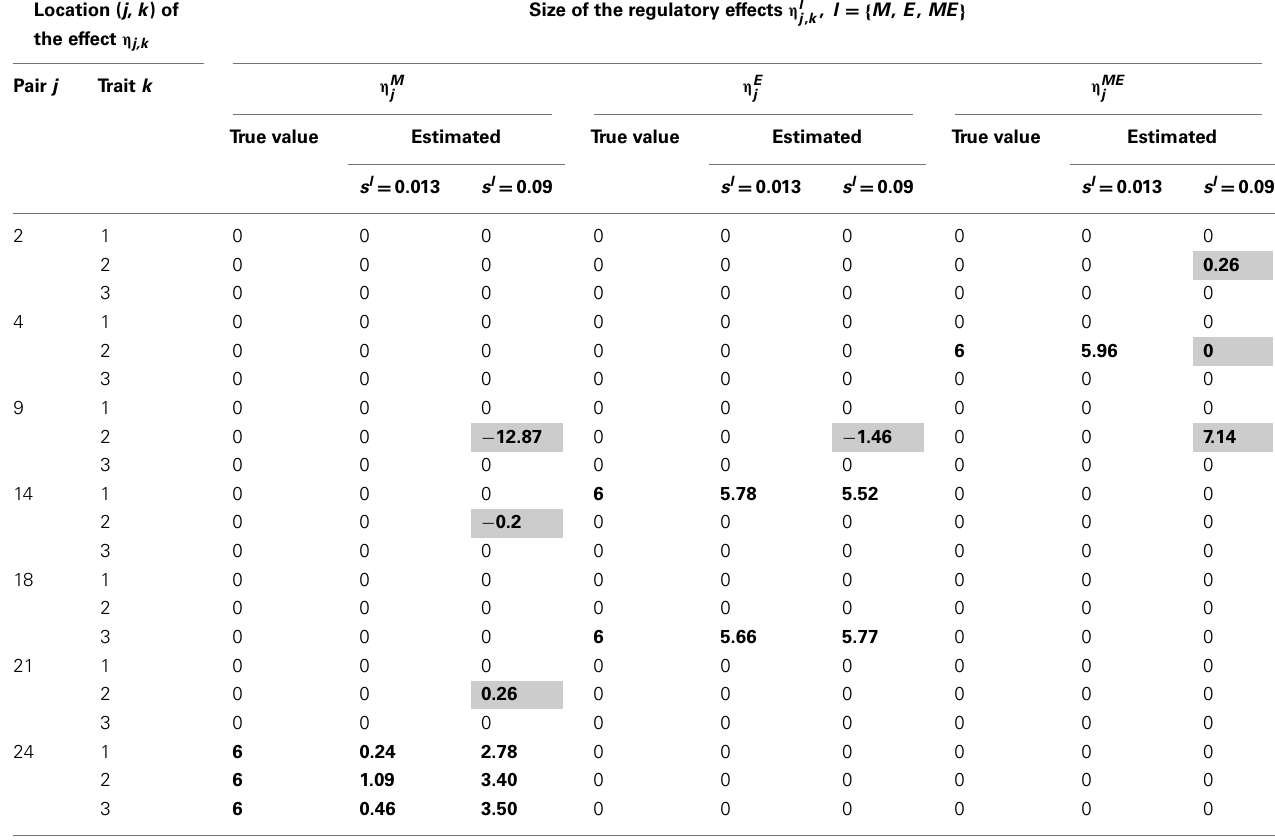
Table 3 |True and estimated (posterior means) cQTL effects under the MD1 version of the HB multi-trait cQTL model with 10% markers and 30% expressions coded as missing and different values of Bernoulli parameter s l . Location ( j , k )